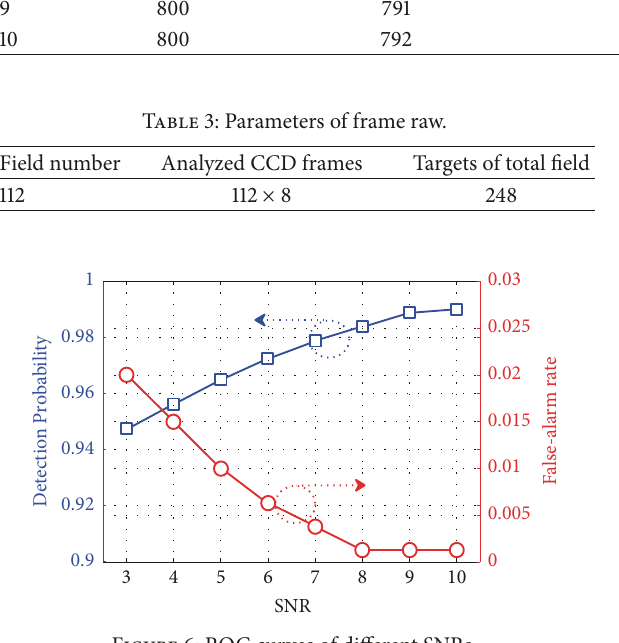
Figure 6: ROC curves of different SNRs.